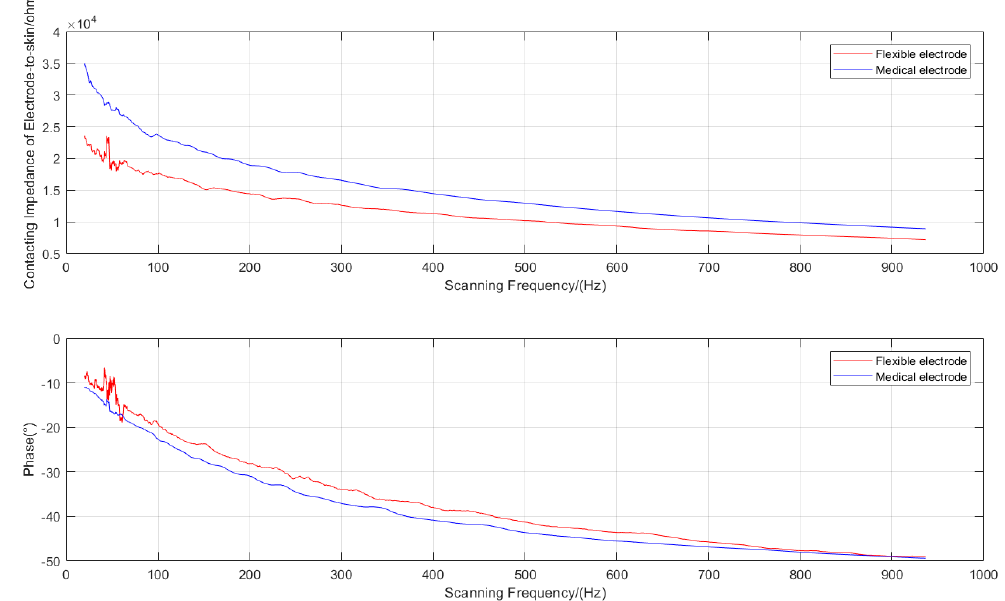
Figure 5. Comparison of skin contact impedance between the commercial electrodes and the flexible electrodes with pyramidal array micro-structure.